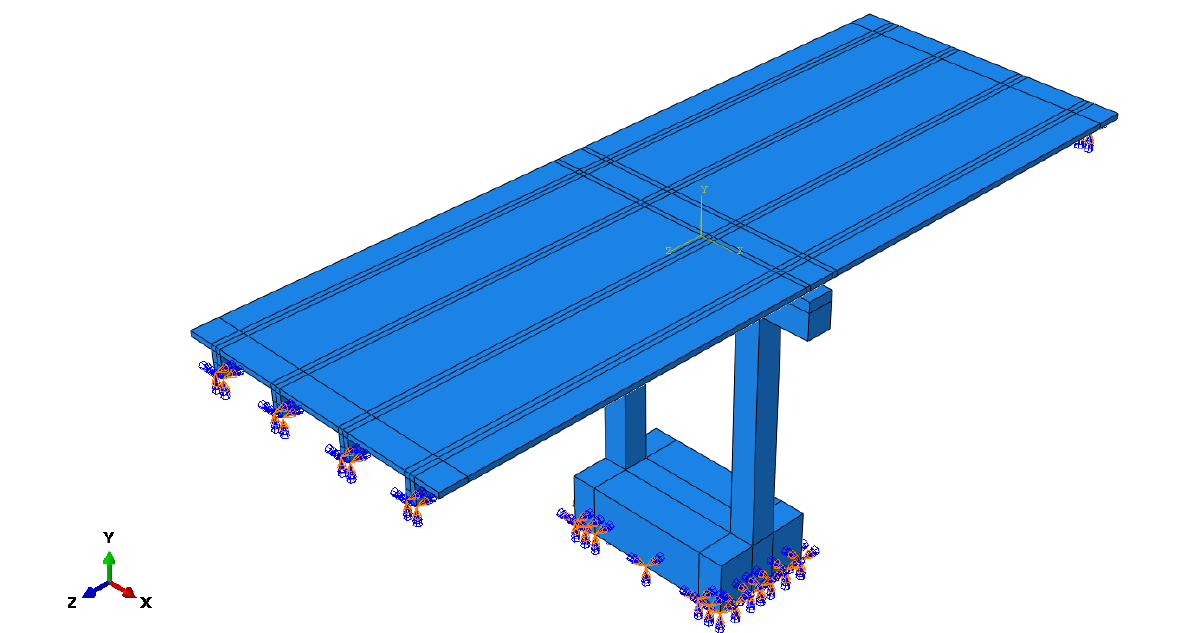
Fig. 7. 3D schematic of the 0° bridge (model